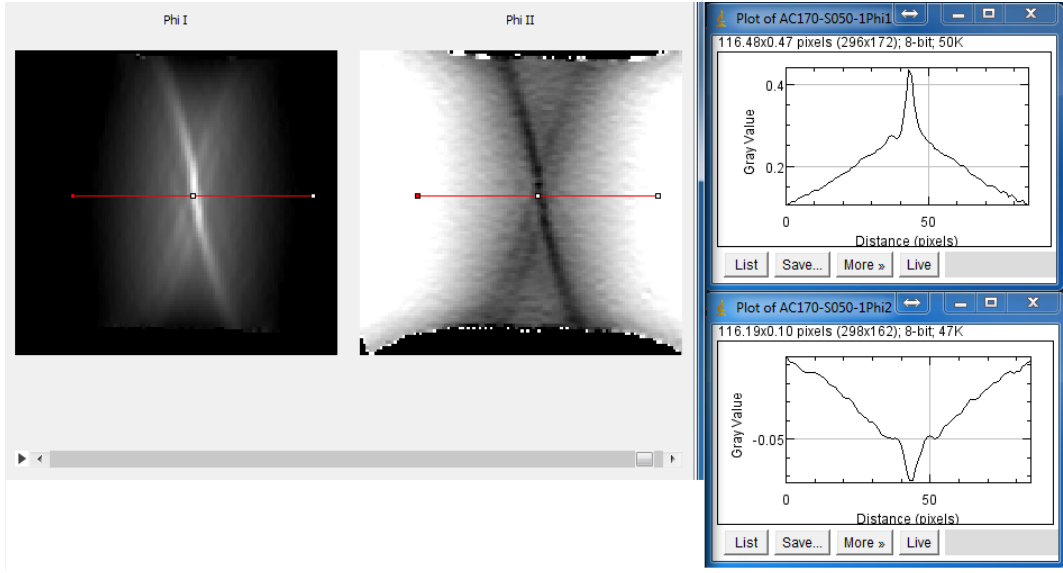
Figure 6. Part of the developed user interface for the collection of experts decisions with on-line cross-sections through the strain